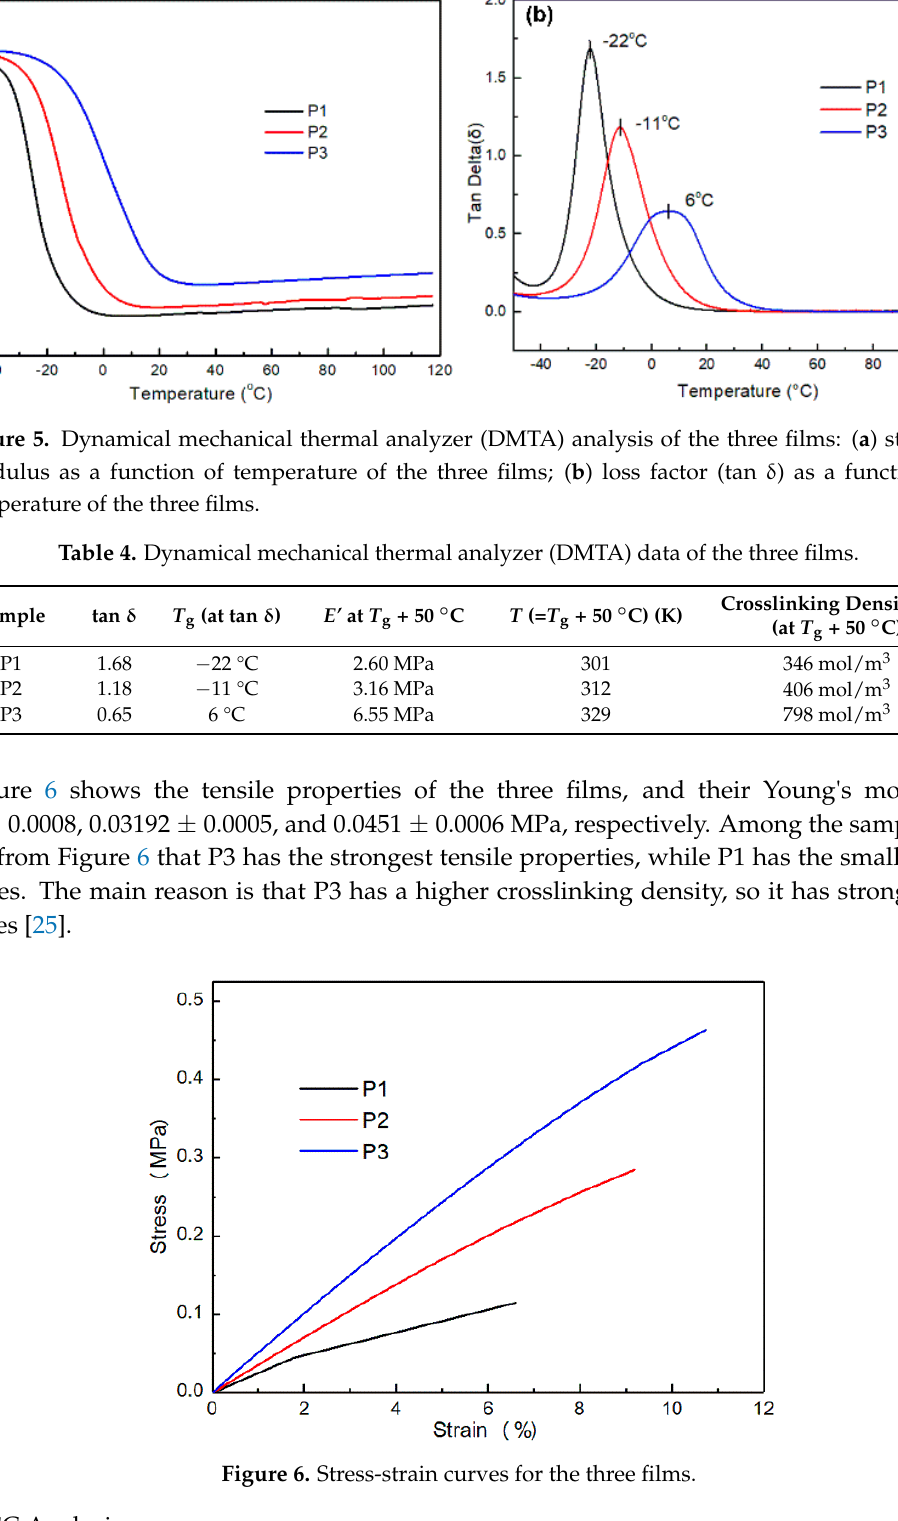
Figure 6. Stress-strain curves for the three films.